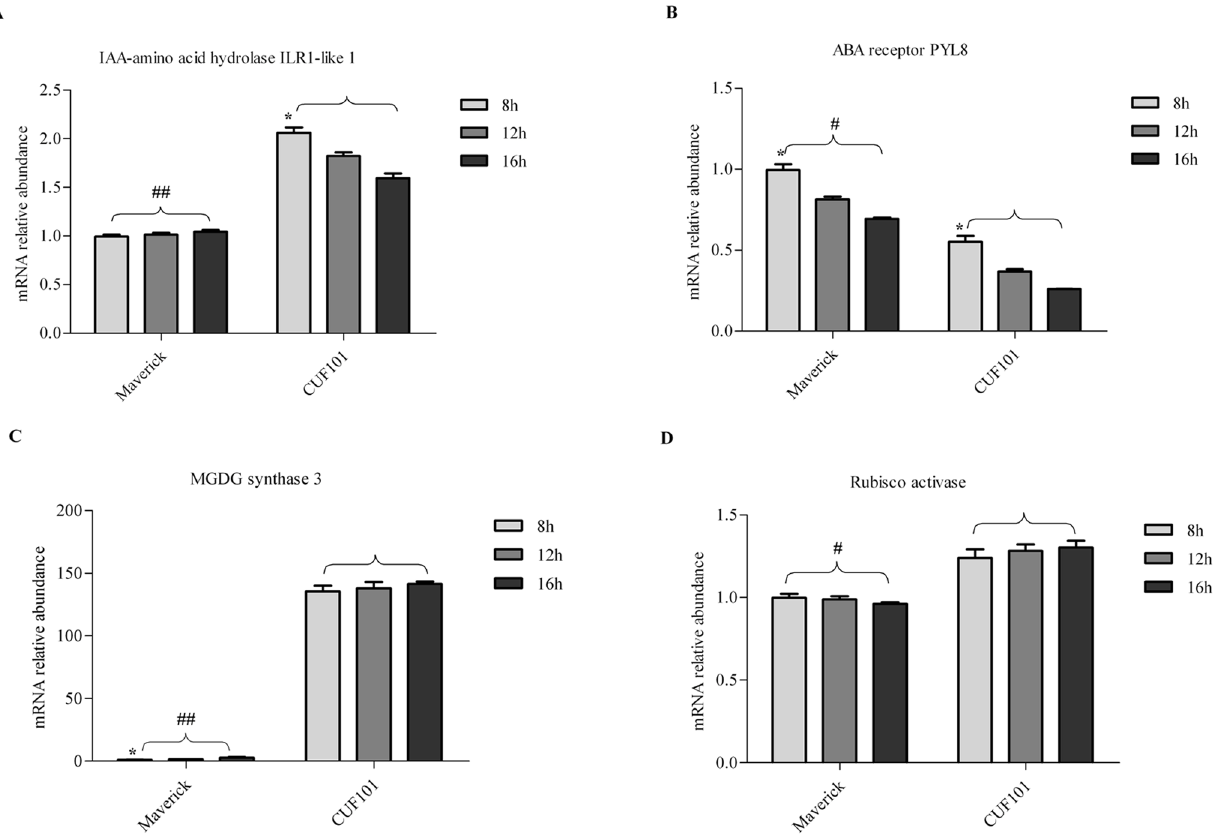
Fig 9. mRNA abundance of four differentially expressedgenes (DEGs) in Maverickand CUF101 varietiesgrown under 8h to 16h daylength and artificial growth conditions. Significant difference in the mRNA content of DEGs at 8h,12h, and 16h of illuminationin each variety is marked with * . Significantdifference in mRNA content betweenthe two varieties is indicatedwith # ( * , #, p < 0.05; ** , ##,p < 0.01). Error bars indicate